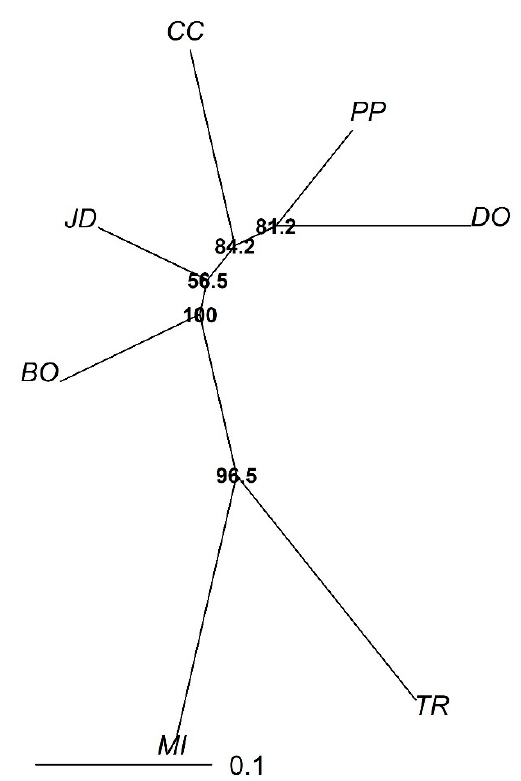
Figure 2. Neighbor-joining dendrogram based on Reynold’s genetic distance from seven microsatellite loci. The graph shows the genetic relationship between the seven Campomanesia adamantium populations: Bonito/MS (BO); Dourados/MS (DO); Jardim/MS (JD); Ponta Porã/MS (PP); Mineiros/GO (MI); Três Ranchos/GO (TR); and Cerro Corá/AY (CC). Numbers at nodes are bootstrap values (1000 bootstraps).